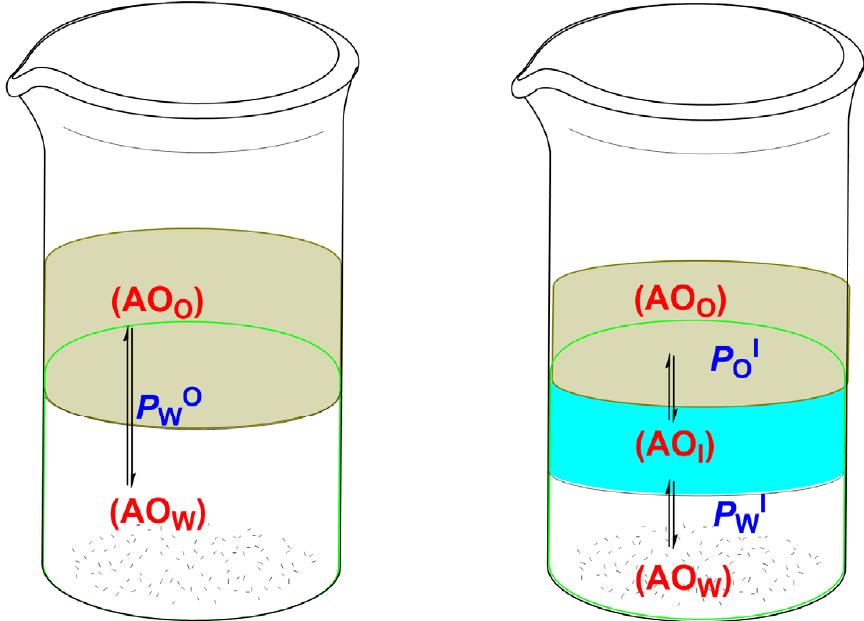
Figure 1. Basic representation of the distribution of an antioxidant (AO) in a binary oil–water system ( left ) and in an emulsified system ( right ) between the oil (O), interfacial (I), and aqueous (W) regions. The solvation spheres of the antioxidant in the different regions are not displayed for the sake of clarity.